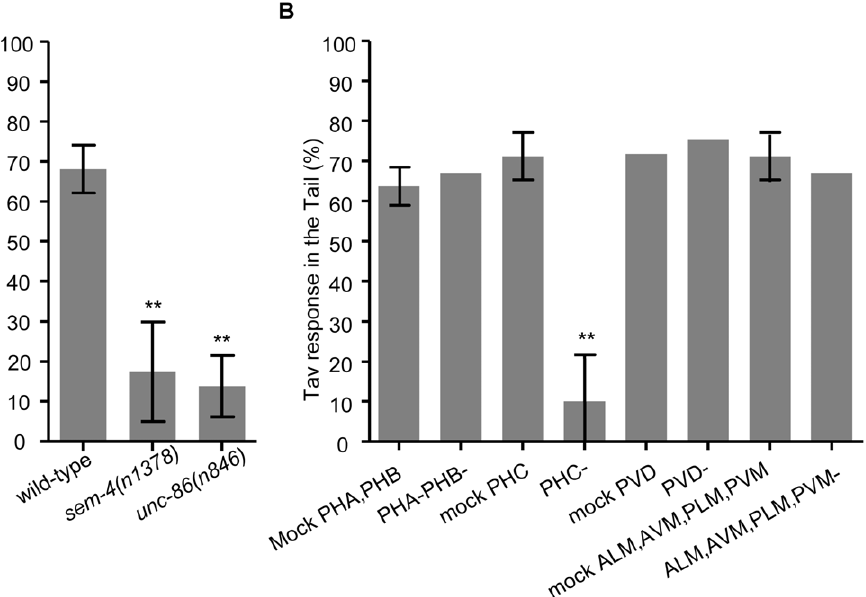
Figure 2. The PHC sensory neurons mediate Tav response in the tail of C.elegans . (A) sem-4 and unc-86 mutants showed strongly reduced tail Tav response (n . 100). (B) Laser-ablation of the PHC neurons almost abrogated the tail Tav response, while ablation of PHA, PHB, PVD and the six touch neurons had no significant defects. (**P , 0.001, n . 8). Error bars indicate SD.